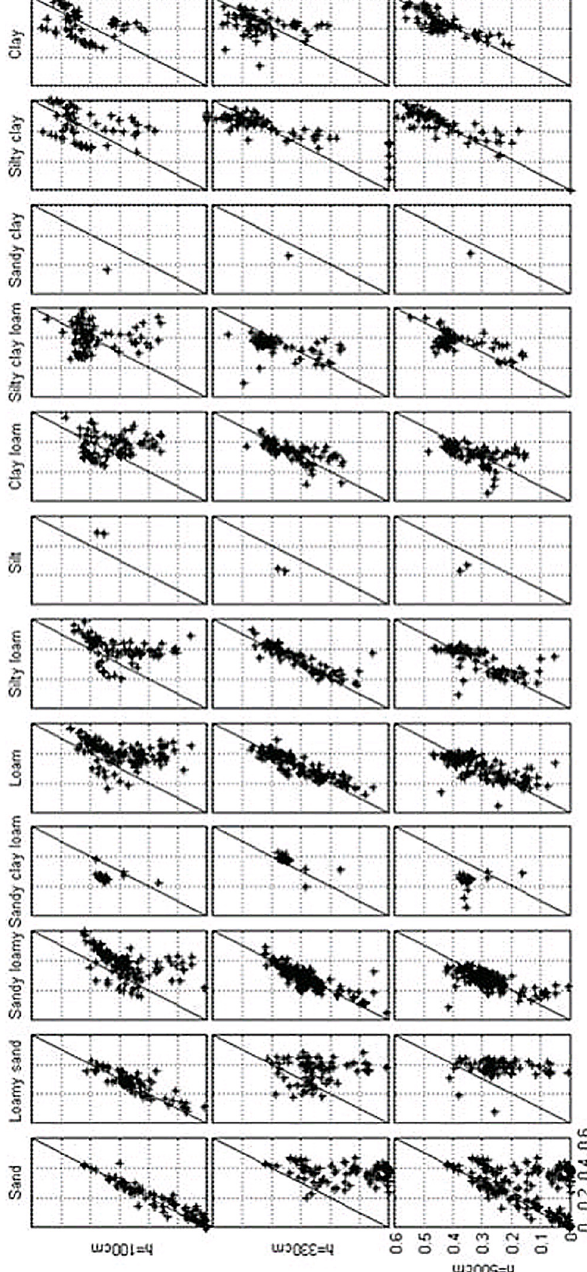
Fig. 4. Scatter plots of field capacity, θ fc drain , as determined by the drain -method versus field capacity values obtained from the water retention characteristics by the fix -method, θ fc fix , for the three suc- tion heads of 100cm, 330cm, and 500cm. Data points refer to 1087 soil samples grouped according to different textural